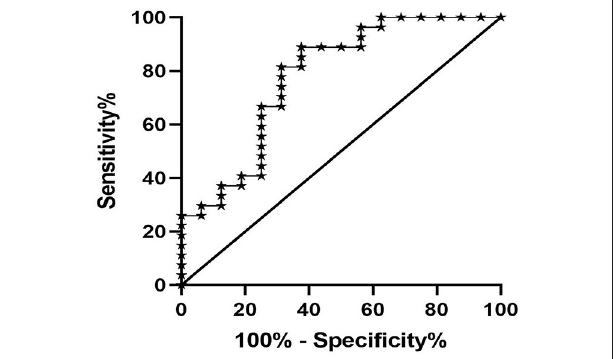
FIGURE 8 | ROC analysis of T1 value in predicting renal fibrosis. The area under the ROC curve was 0.762, the optimal cut-off value was 1,695ms, the specificity was 0.778, and the sensitivity was